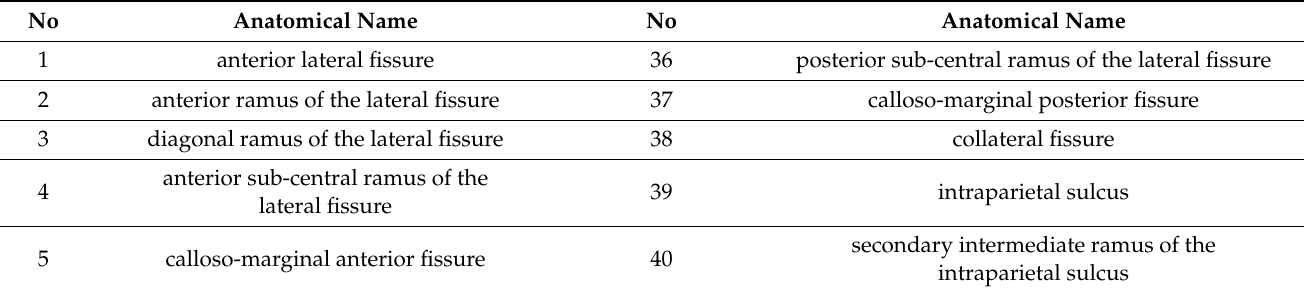
Figure 2. The specific FCs identified for ASD/SSD/MDD classifiers. The 70 terminal regions connected by the FCs are numbered as described in Table 1. The state of FC exhibiting the smaller (more negative) and greater (more positive) correlations than the healthy control is termed under- and over-connectivity, respectively. Specific FCs identified for ( a ) ASD [105], ( b ) SSD [116], and ( c ) MDD classifiers [117], are illustrated. These three classifiers are summarized in ( d ), where they did not overlap. Table 1. The identified terminal regions in ASD/SSD/MDD classifiers. The terminal regions identified for ASD/SSD/MDD classifiers are numbered. See Figure